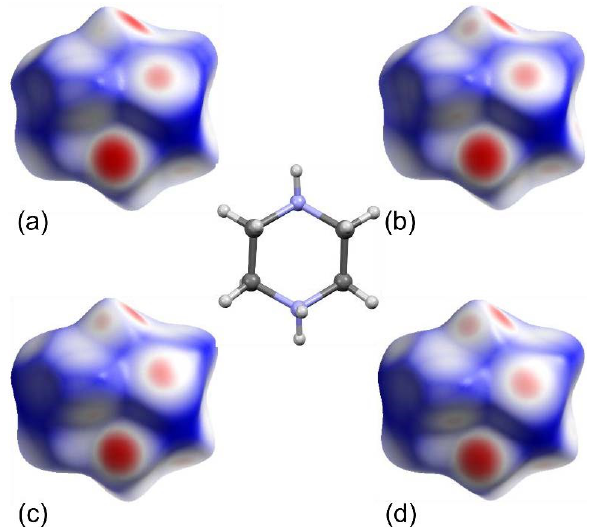
Figure 3. Hirshfeld surfaces mapped with d norm for the piperazine-1,4-diium cations in 1 and 2 at 295 ( a , c ) and 85 K ( b , d ), respectively. The overlapping surfaces are marked in red, touching in white, whereas separated in navy